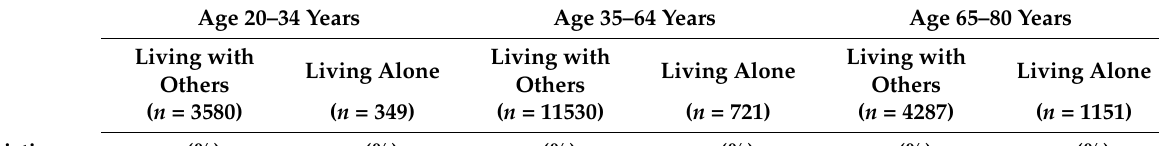
Table 1. Sociodemographic characteristics of individuals living alone and those living with others in South